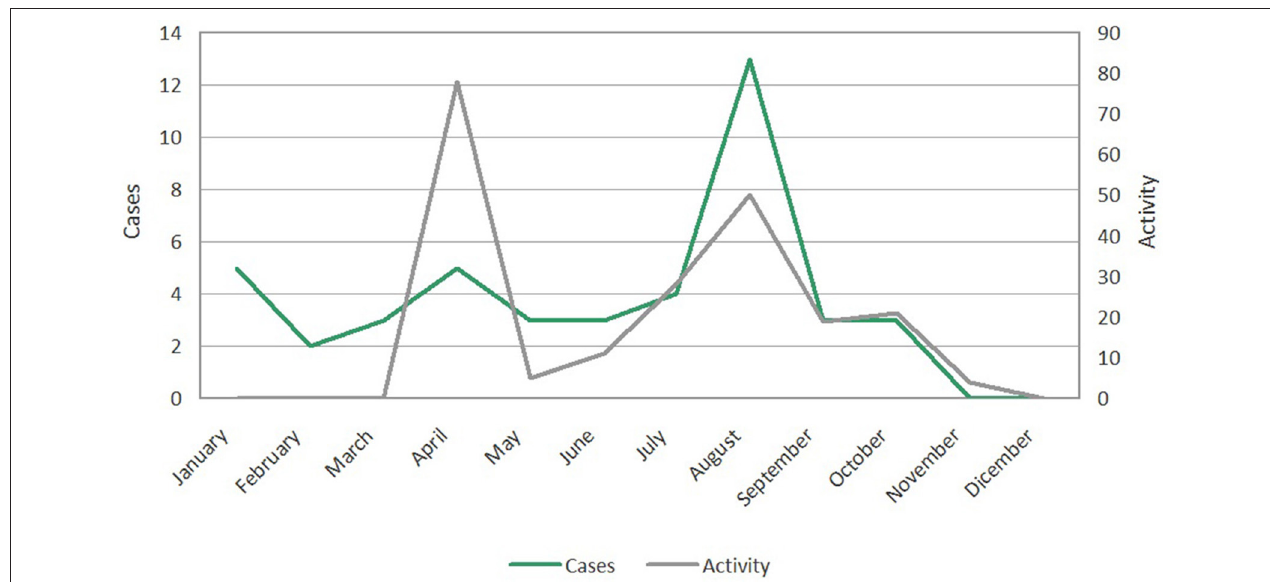
FIGURE 6 | Distribution of the Zika virus and Aedes albopictus vector activity (number of larval hatcheries detected on the public road) by month in the city of